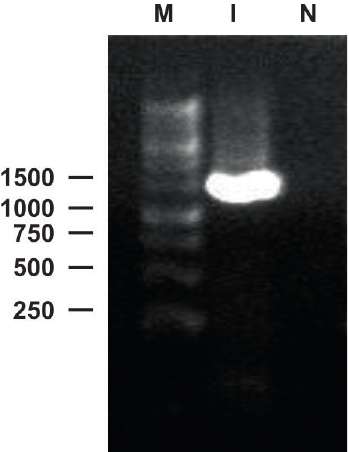
Fig. 5 . 16s rRNA PCR profiles of 27 F and 1492 R primers, generated from bacterial genomic DNA. M: DNA ladder, I: PCR product, N: Negative